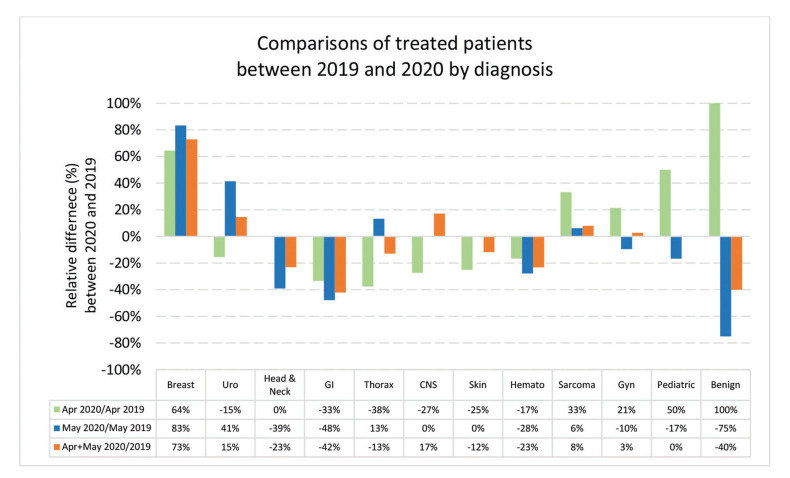
Comparison between April and May 2019 and April and May 2020 by diagnosis of treated patients. Legend: Uro = urological cancers (most prostate); GI = gastrointestinal cancers; CNS = Central nervous system tumors; Hemato = hematological cancers; Gyn = gynecological cancers.